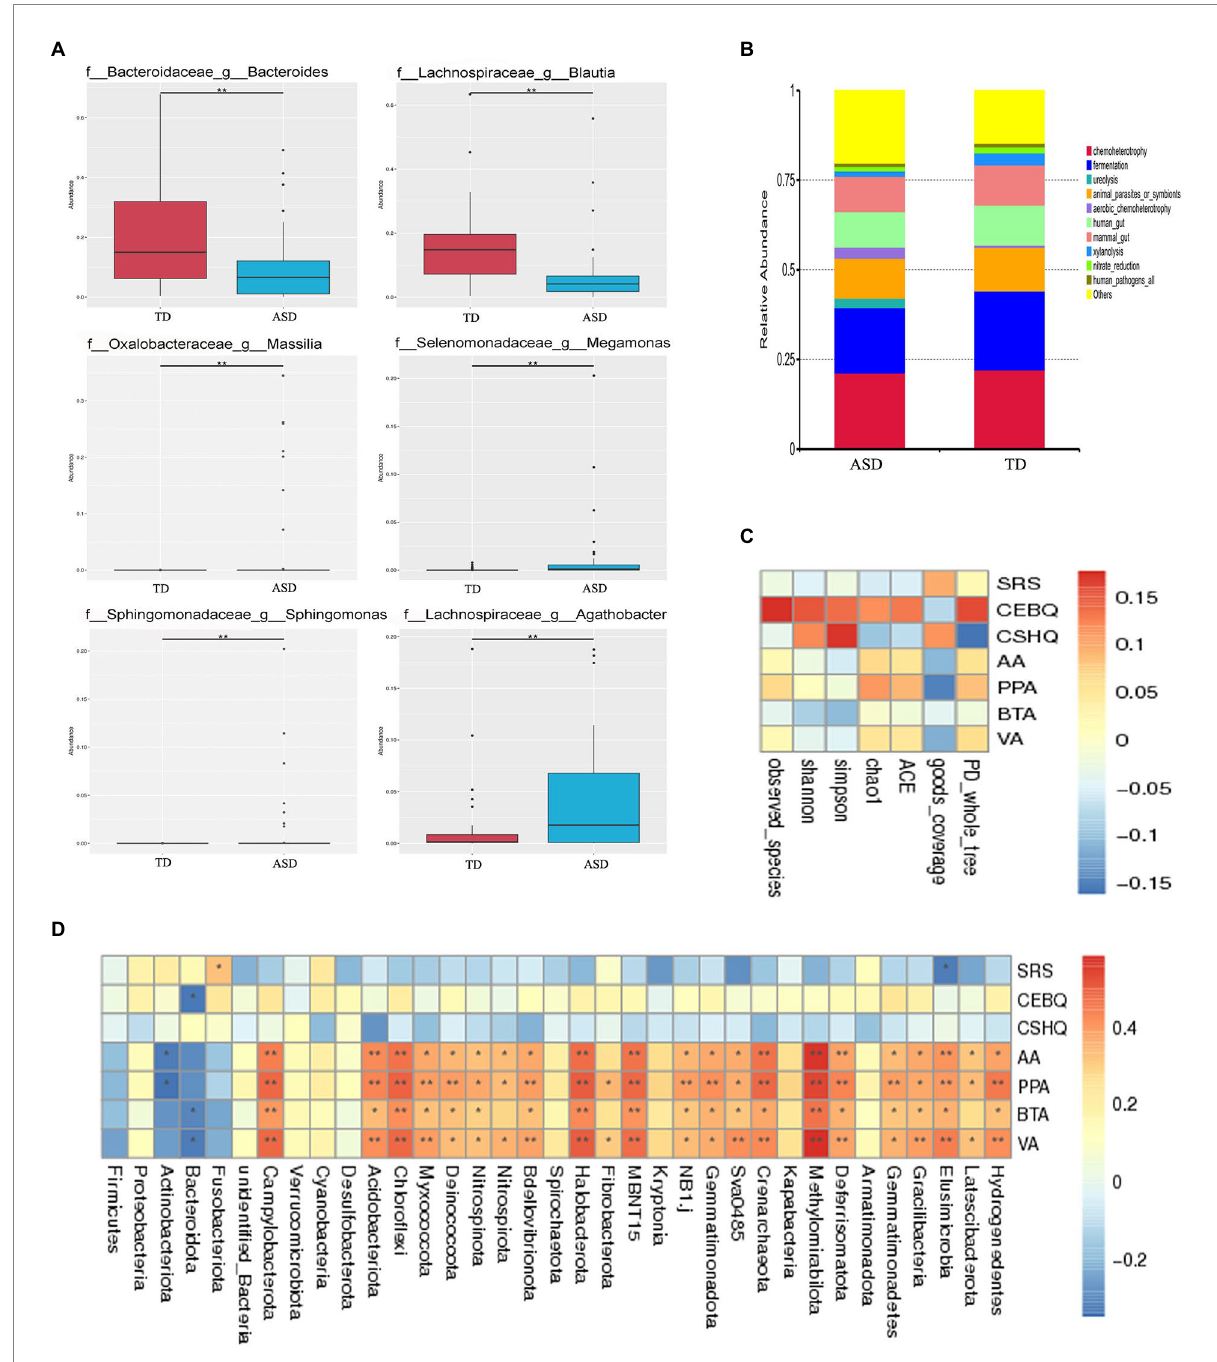
FIGURE 3 The specific microbial changes between the two groups and their associations with SCFAs. (A) The top 6 relative abundance genus levels of gut microbiota between the TD and ASD groups based on metastat analysis. (B) The FAPROTAX database was used to predict the functions of bacteria in both groups. (C) Spearman correlation analysis of the association between fecal SCFA and sociality, eating, sleep questionnaire scores in alpha diversity, and (D) in the phylum level in the ASD